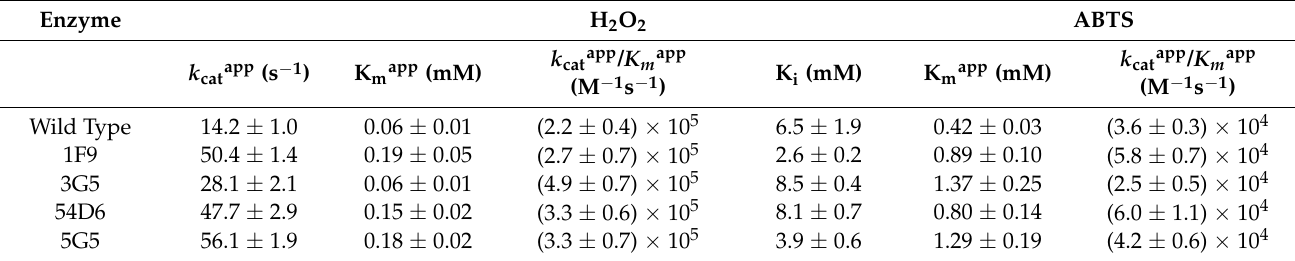
Table 2. Apparent steady-state kinetic parameters of wild type and variants for hydrogen peroxide and ABTS, measured at 25 ◦ C and pH 4.2. Enzyme